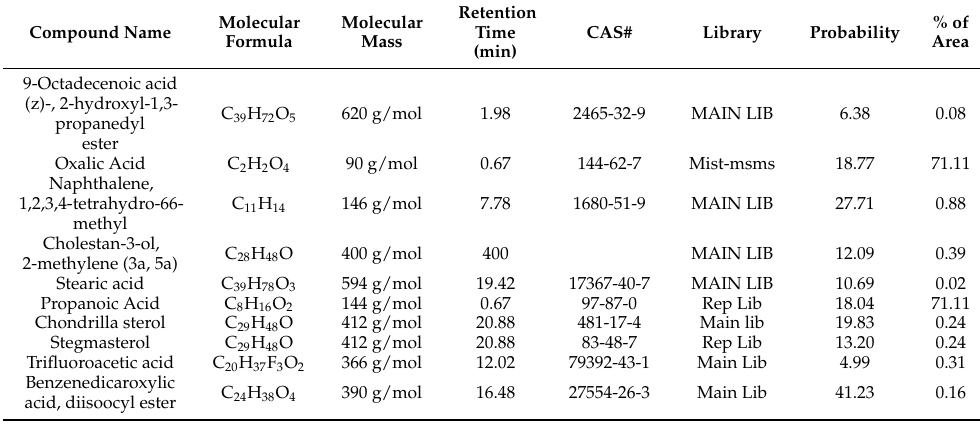
Table 5. Major constituents of bacterial extract H1 (A1S10) were identified by GC–MS